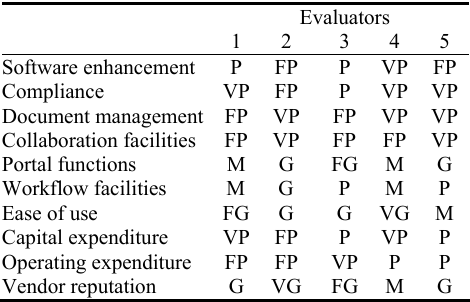
Table 5. The linguistic evaluation of alternative B